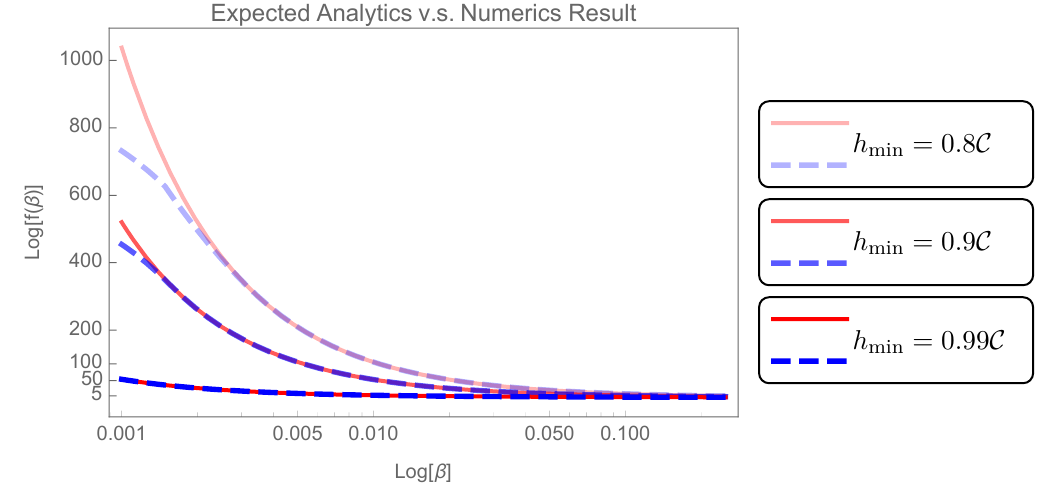
Figure 2 . Comparison of analytic t-channel crossing with results of numerical integration over kernel ansatz for relevant values of h min . The solid red lines display the functional form expected from the t-channel crossing, given by the righthand side of (4.2). The dashed blue lines exhibit successive results of numerically integrating over the kernel